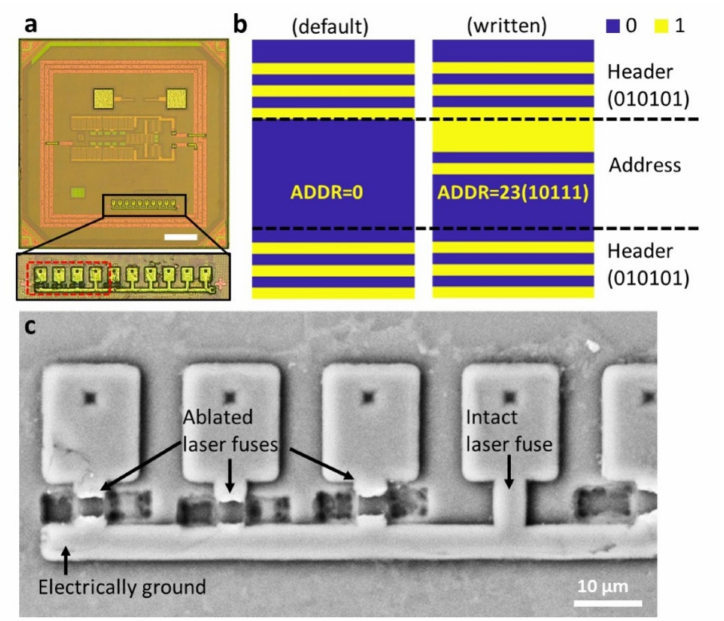
Figure 6. ( a ) A microscope image of a CMOS chip with 500 µ m × 500 µ m sized RF on-chip antenna coil and a close-up view of an embedded 10-bit fuse structure. Scale bar: 100 µ m. ( b ) Validation of addressing from RF backscattered data for the 10-bit address and an interleaved header sequence (010101) [35]. Default code is 10b’0; the laser-written address sets a distinctive identity (10111 = 23 in this case). ( c ) SEM image of the one fuse structure after the laser ablation process.